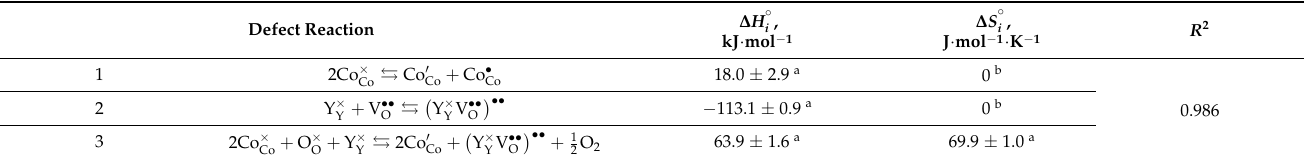
Table 2. Results of the defect structure analysis of YBC.